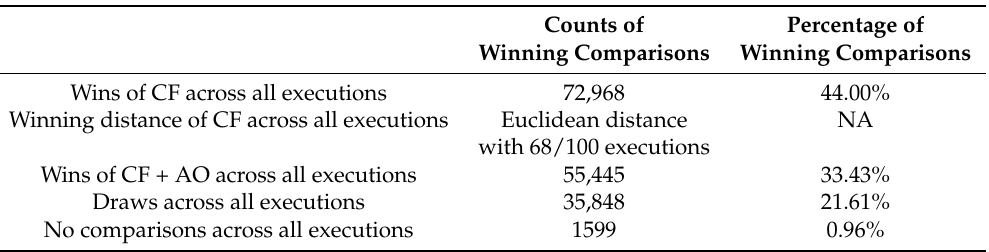
Table 6. Comparison between the recommendations given by the user-based CF against the user-based CF with an average aggregation operator that integrates nine similarity measures. Counts